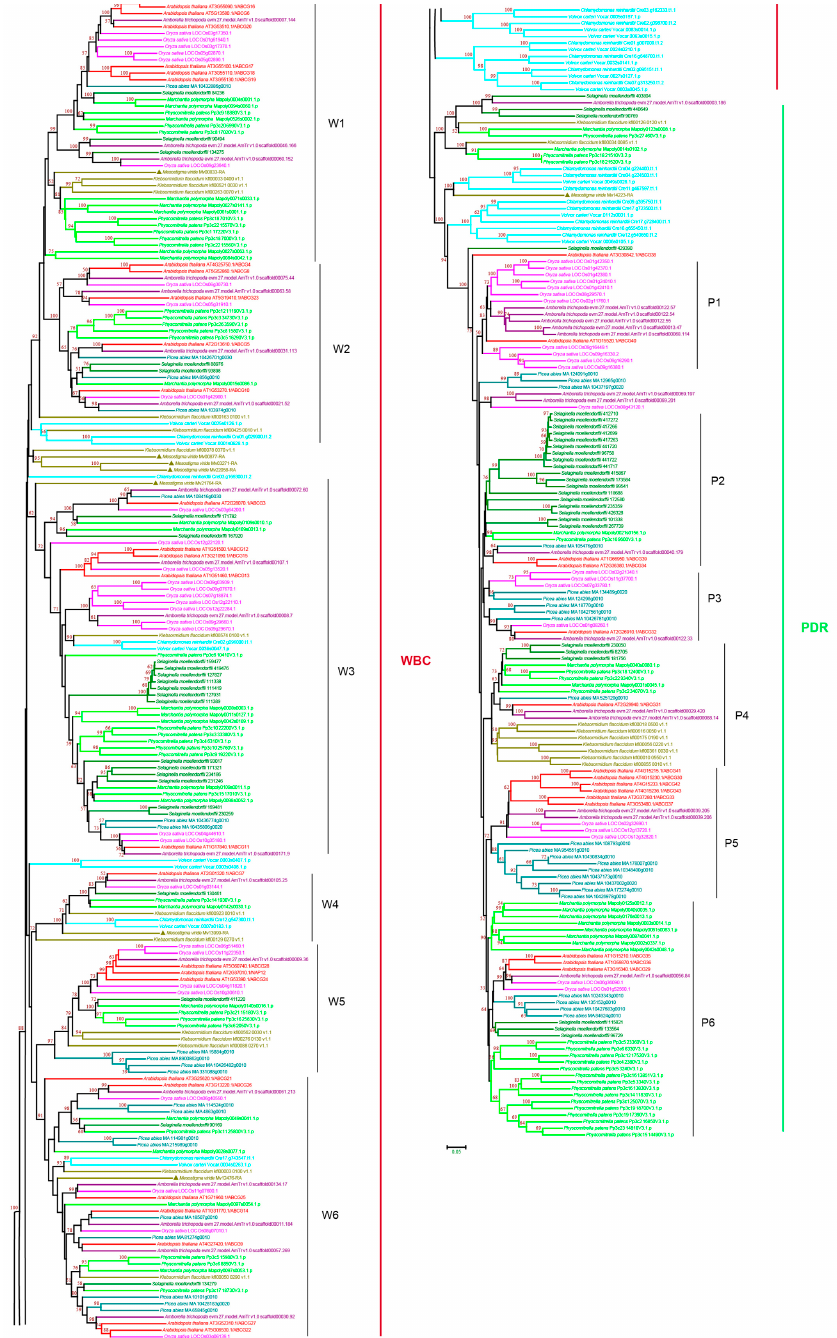
Figure 8. Phylogenetic analysis of ABCG subfamily proteins from 11 evolutionarily representative plant species. A neighbor-joining (NJ) tree was generated using MEGA7 with 1000 bootstrap repli- cates, and bootstrap values >50% are shown on the branches. ABCGs include two major groups: the white–brown complex (WBC), and pleiotropic drug resistance proteins (PDRs). The M. viride proteins are highlighted by